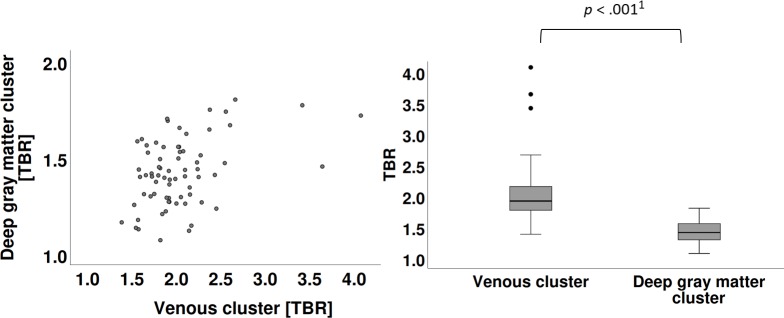
Scatterplots of TBR.A Scatterplot of TBR of venous cluster with TBR of deep gray matter cluster. B Significant difference in the TBR values were identified for venous cluster (M = 2.03, SD = 0.46) and deep gray matter cluster (M = 1.42, SD = 0.17), paired sample t-test, 1
p = 6.312E-19.